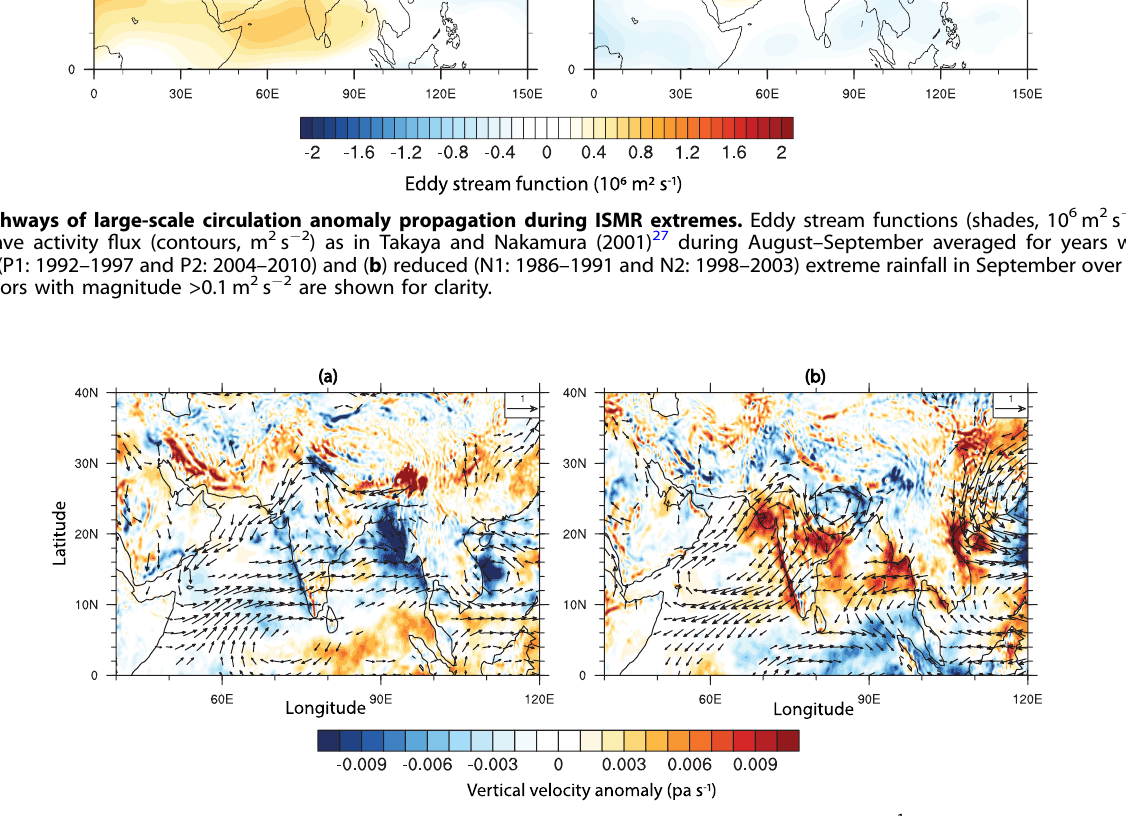
Fig. 4 Effect on circulation changes over the Monsoon region. Vertical velocity anomaly (shaded, Pa s − 1 ) and 850 hPa wind anomalies (vector, m s − 1 ) during September for a increased (P1: 1992 – 1997 and P2: 2004 – 2010) and b reduced (N1: 1986 – 1991 and N2: 1998 – 2003) extreme rainfall in September over central India. Vectors with magnitude >0.2 m s − 1 are shown for clarity.